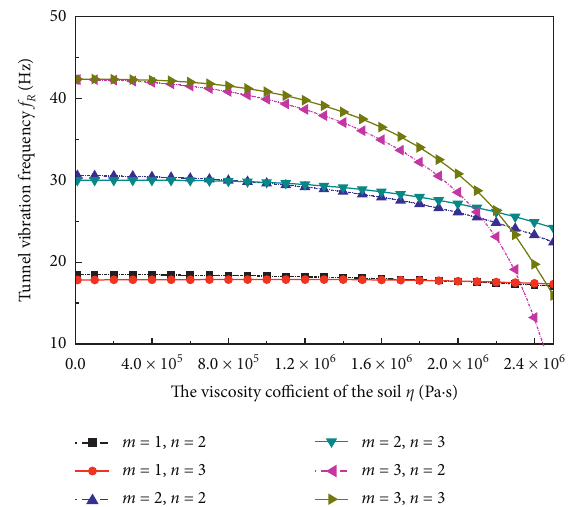
Figure 2: Relationship between natural frequency of the tunnel and changes in soil viscosity for different modes.